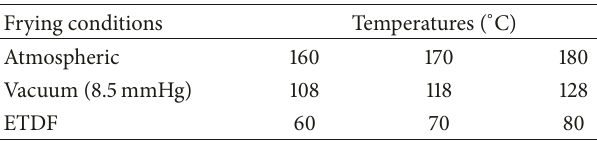
Table 1: Experimental conditions for atmospheric and vacuum frying